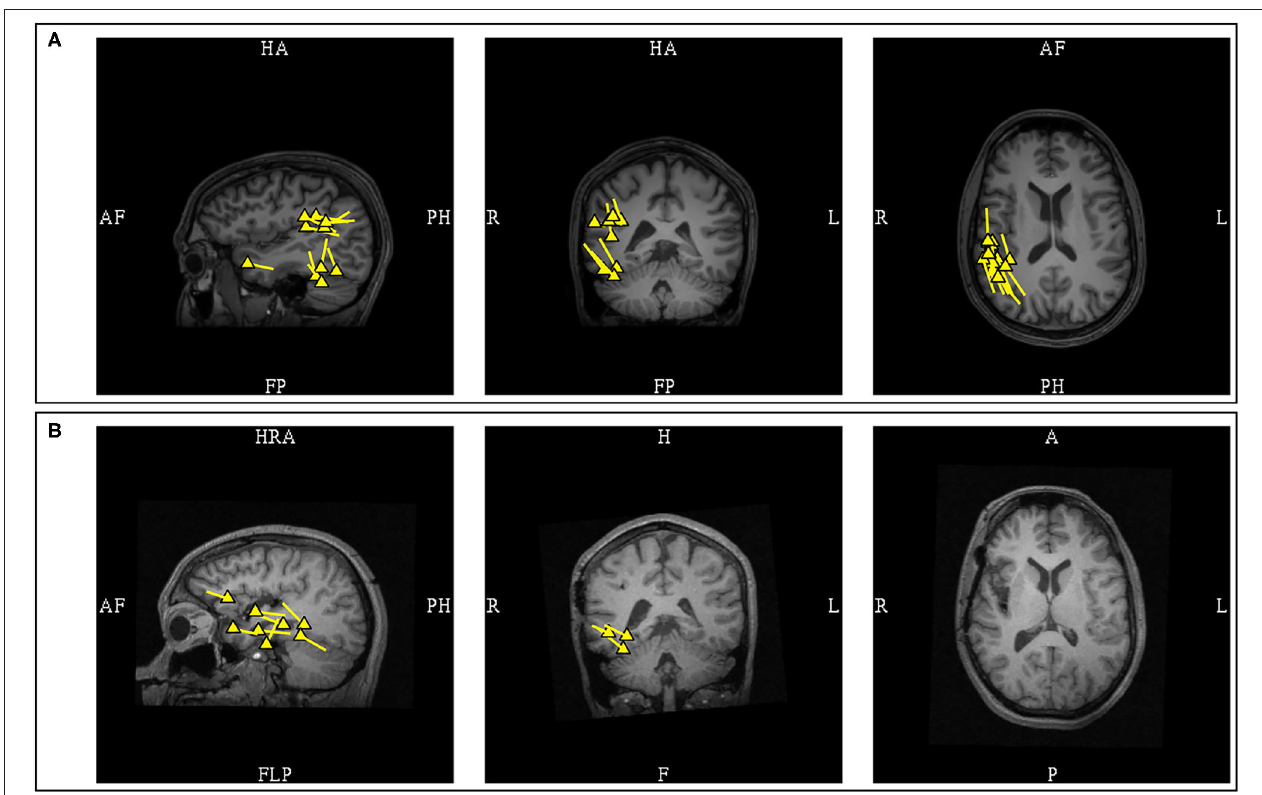
FIGURE 15 | MEG-MRI coregistration summary in a patient with a previous right anterior temporal laser ablation who underwent posterior insular resection. (A) Pre-operative MEG showed multifocal clusters over the right supramarginal, posterior basal temporal, and anterior temporal regions. The supramarginal cluster in this patient was pathologic due to presence of an epileptiform correlate. Invasive EEG recording confirmed interictal spiking concordant with MEG. (B) Post-operative MEG after the posterior insular resection showed disappearance of the supramarginal cluster, but the temporal dipoles